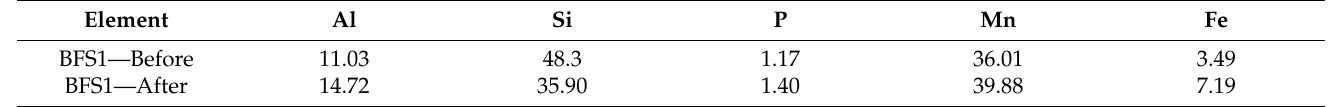
Table 3. Main elements and content in the surface of BFS (atom %).